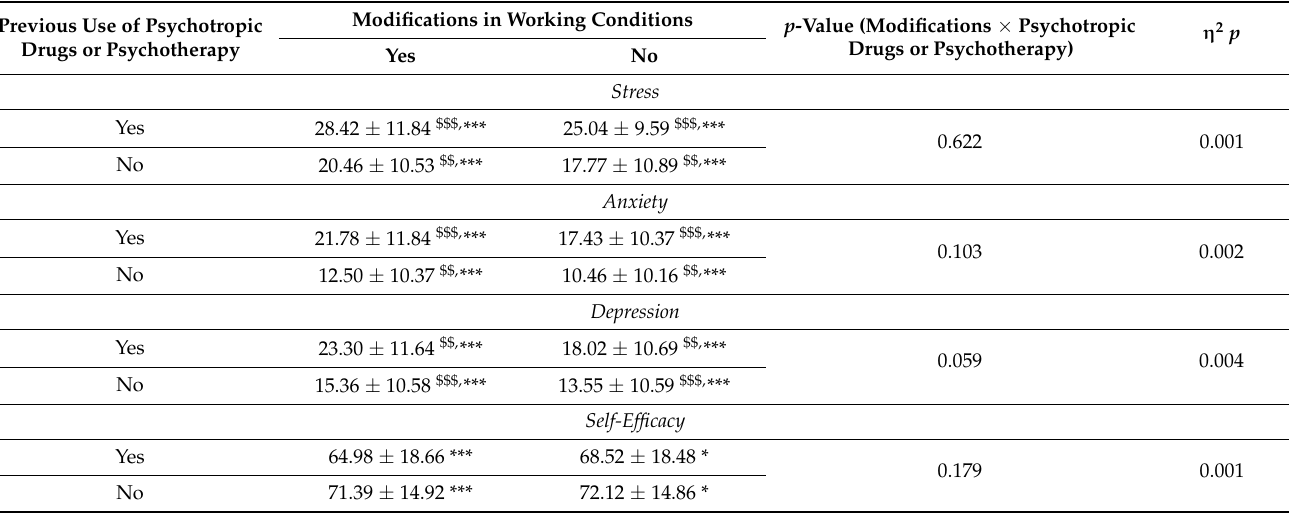
Table 6. Level of stress, anxiety, depression, and self-efficacy according to modifications in working conditions and previous use of psychotropic drugs or